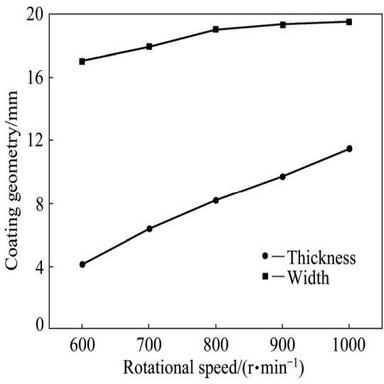
ffect of rotational speed on coating geometry